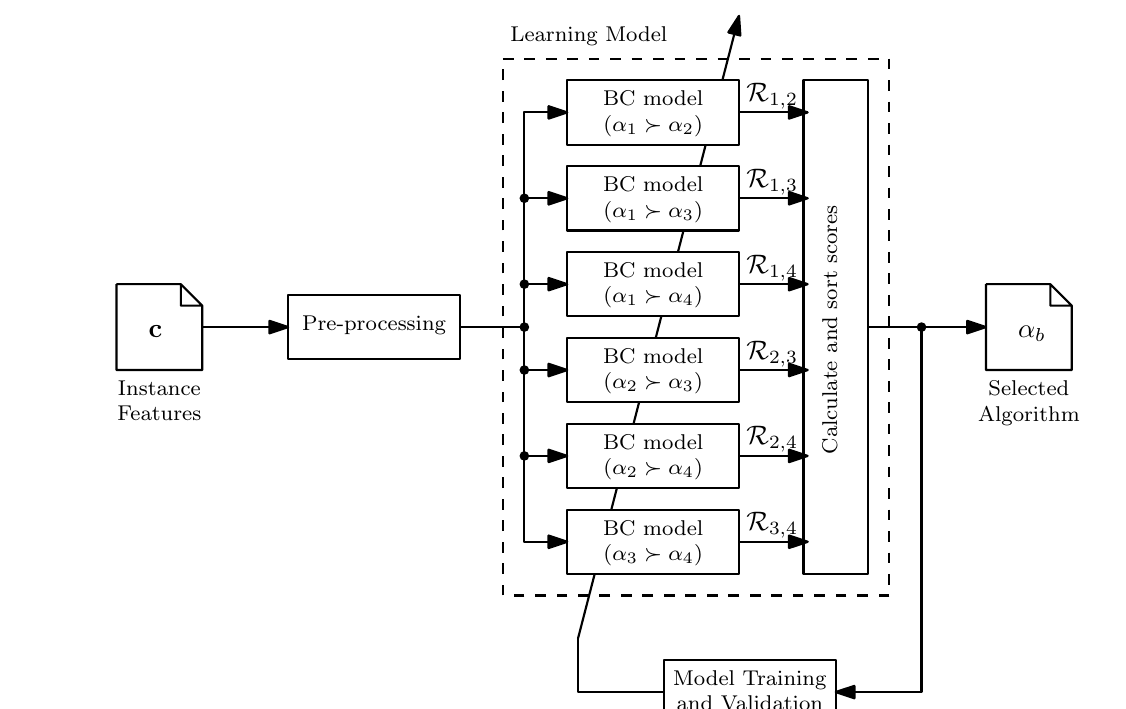
Figure 3. Structure of the multi-class learning model for A = { α 1 , α 2 , α 3 , α 4 } . The six BC models take the vector ELA features c as input and generate a probability score, R as